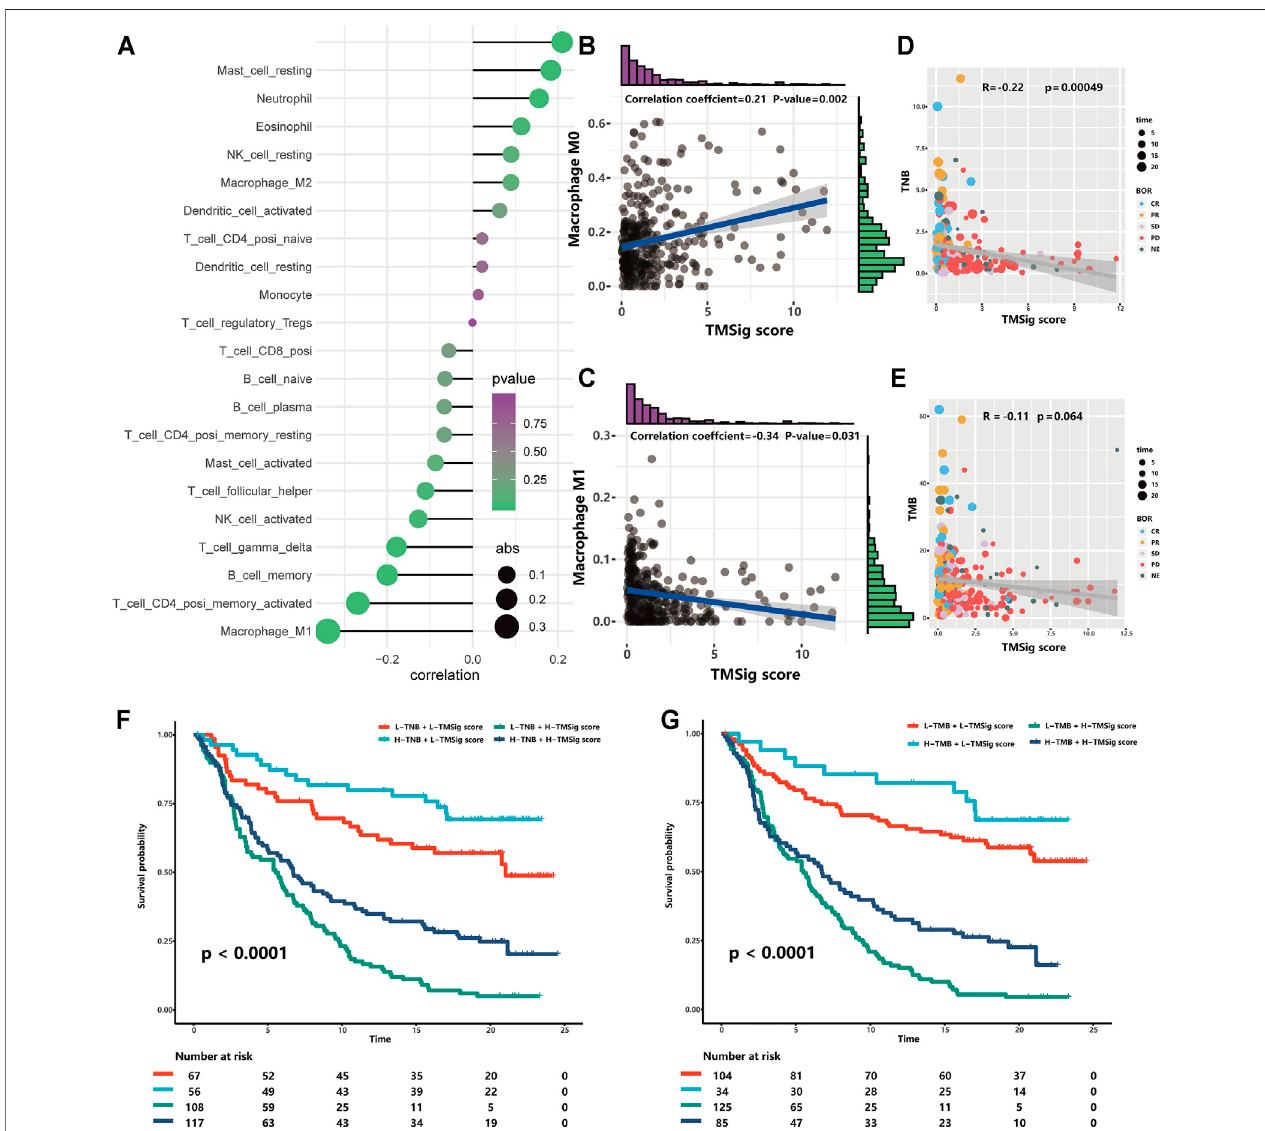
FIGURE4| TheassociationofTMSigscorewithimmune-associated cells, TMBandTNB. (A) Thecorrelation ofTMSigscorewithimmune cellin fi ltration level.The depth of the color represents the p -value and the size of the dot represents the absolute value of the correlation coef fi cient. (B) The correlation of TMSig score with M0 Macrophage. (C) The correlation of TMSig score with M1 Macrophage. (D) Modest but signi fi cant correlation of TMSig score with TNB. (E) The correlations of TMSig score with TMB. (F) Kaplan-Meier curves for patients strati fi ed by both TNB and TMSig score. (G) Kaplan-Meier curves for patients strati fi ed by both TMB and TMSig